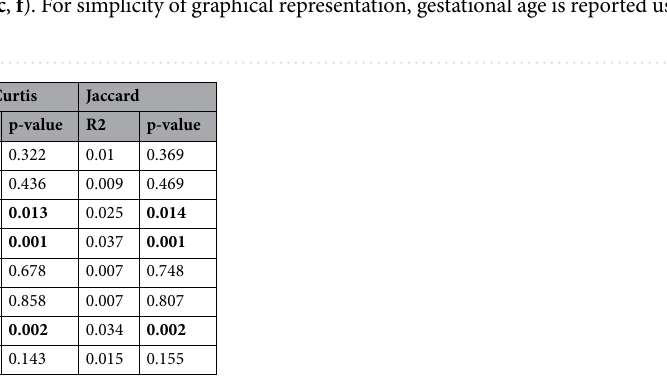
Table 3. Results of the PERMANOVA test using Bray–Curtis and Jaccard dissimilarities. Significant values are in bold. a The sequential test was done adjusting for the used DNA extraction batch.